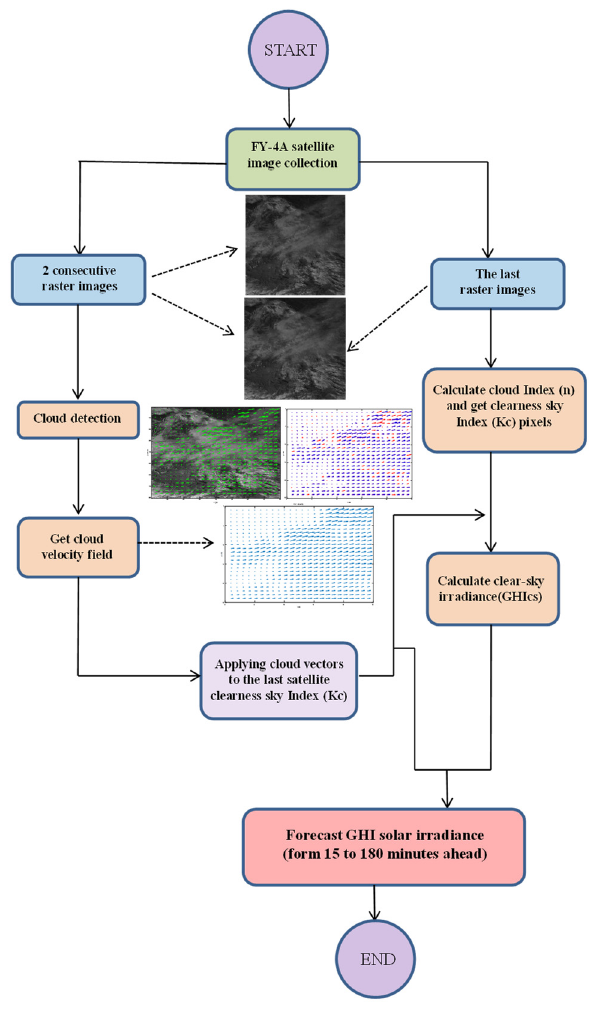
Figure 3. Flow chart of the main steps of global horizontal solar irradiance (GHI) forecasting with time horizons from 15 to 180 min.